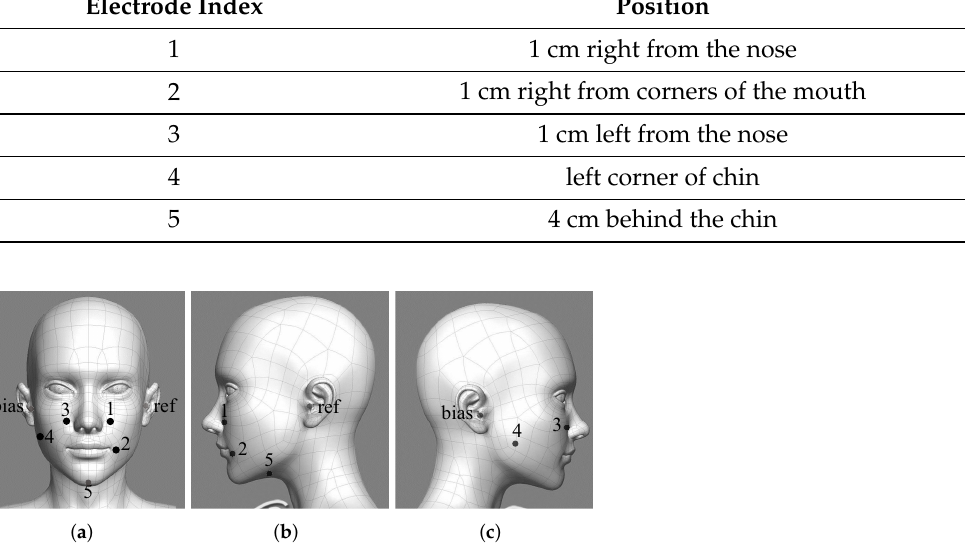
Figure 1. Three views of electrode distribution around the face and neck. ( a ) Main view, ( b ) right view, ( c ) left